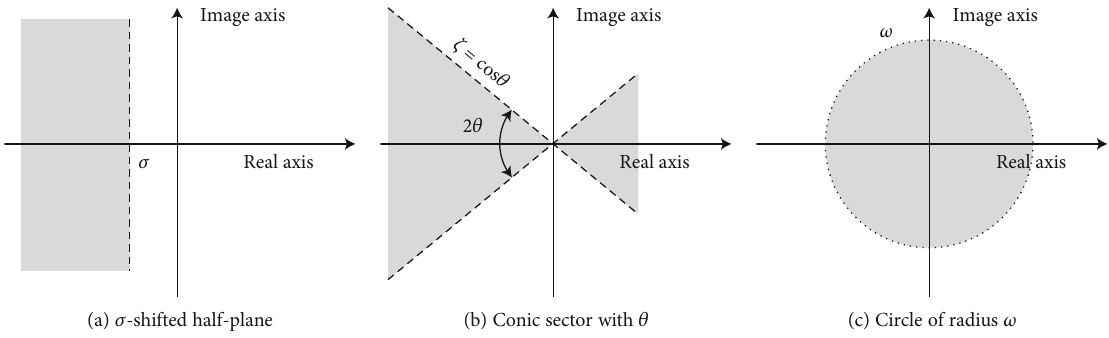
Figure 1: Classical regions Ω in the complex